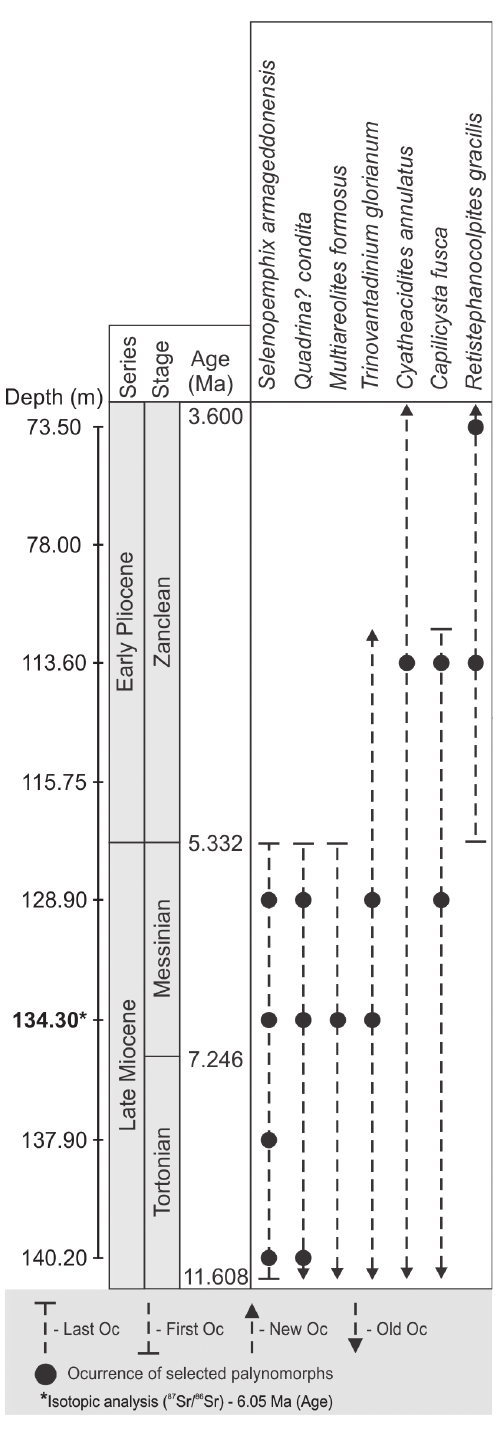
Fig. 7 - Stratigraphic range and occurrence of certain taxa of palynomorphs along the studied samples and their correspondent as discussed in the text. (Last Oc: Last Occurrence, First Oc: First Occurrence, New Oc: Newer Occurrence, Old Oc: Older